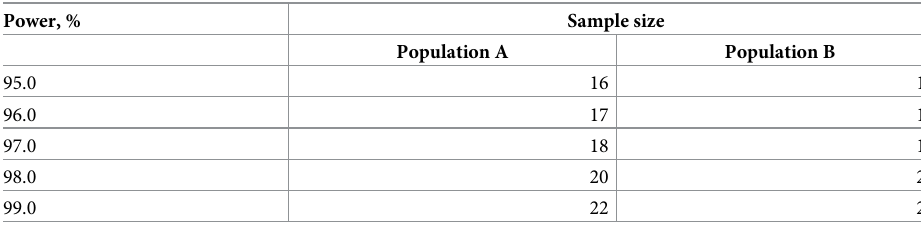
Table 3. Sample size Calculation